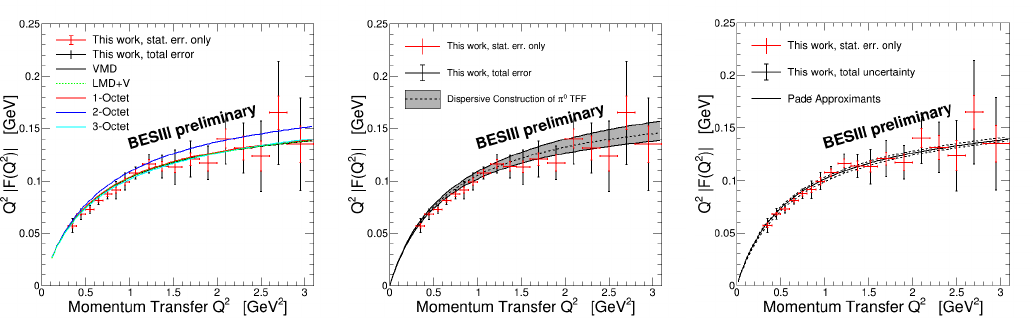
Figure 5: The comparison of the TFF of π 0 with model calculations (left), dispersive approach (middle), and Pad´e approximant (right). The dots with error bars are from the BESIII measurement, the curves with bands are from theoretical